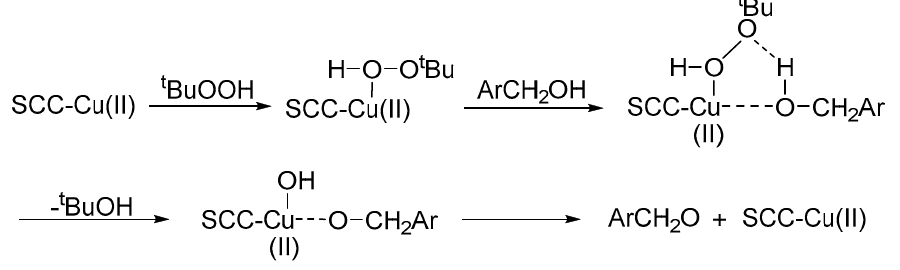
3l /97% a Reaction conditions: 0.5 mmol diarylmethane, SCC (1 mol %), TBHP (3.0 equiv.),